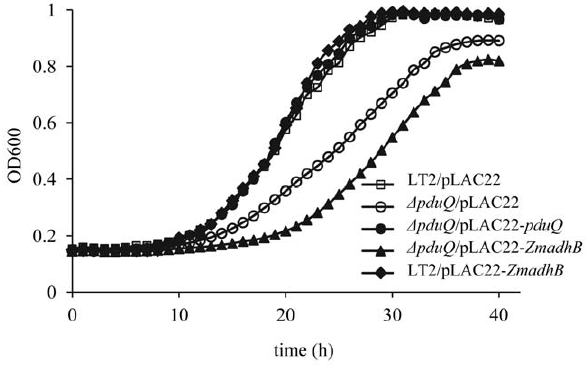
Figure 4. The Adh2 enzyme from Z.mobilis failed to comple- ment a pduQ deletion mutant. Cells were grown in 1,2-PD minimal medium with 75 nM CN-Cbl (vitamin B 12 ). 10 m M IPTG was used for induction of pduQ and 10–500 m m IPTG was used for induction for ZmadhB from pLAC22.